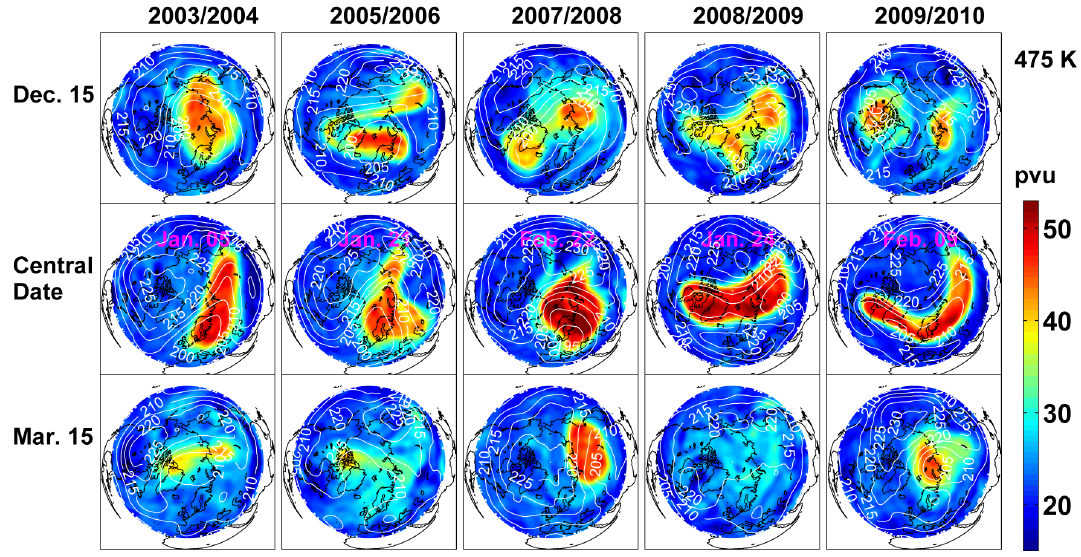
Fig. 5. Same as Fig. 4, but for 475K ( ∼ 85hPa/18km).